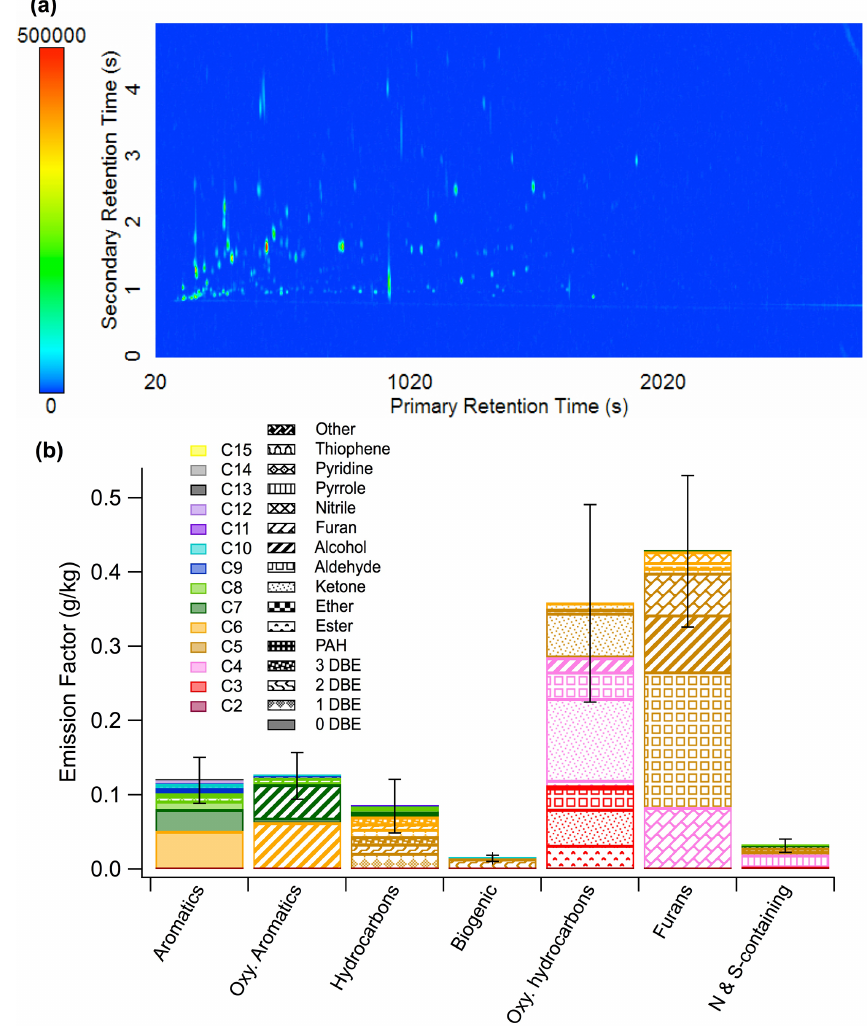
Figure 4. As in Fig. 1, for a wiregrass